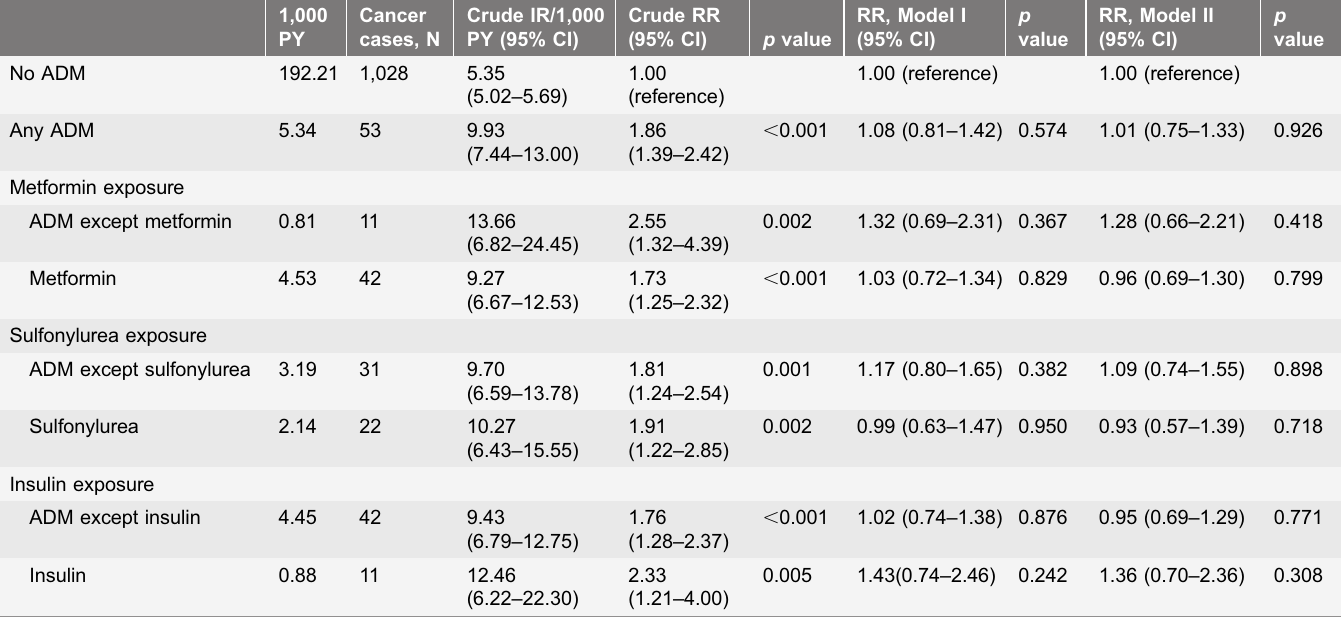
Table 2. Risk ratio of cancer incidence for users of ADM vs. non-users according to